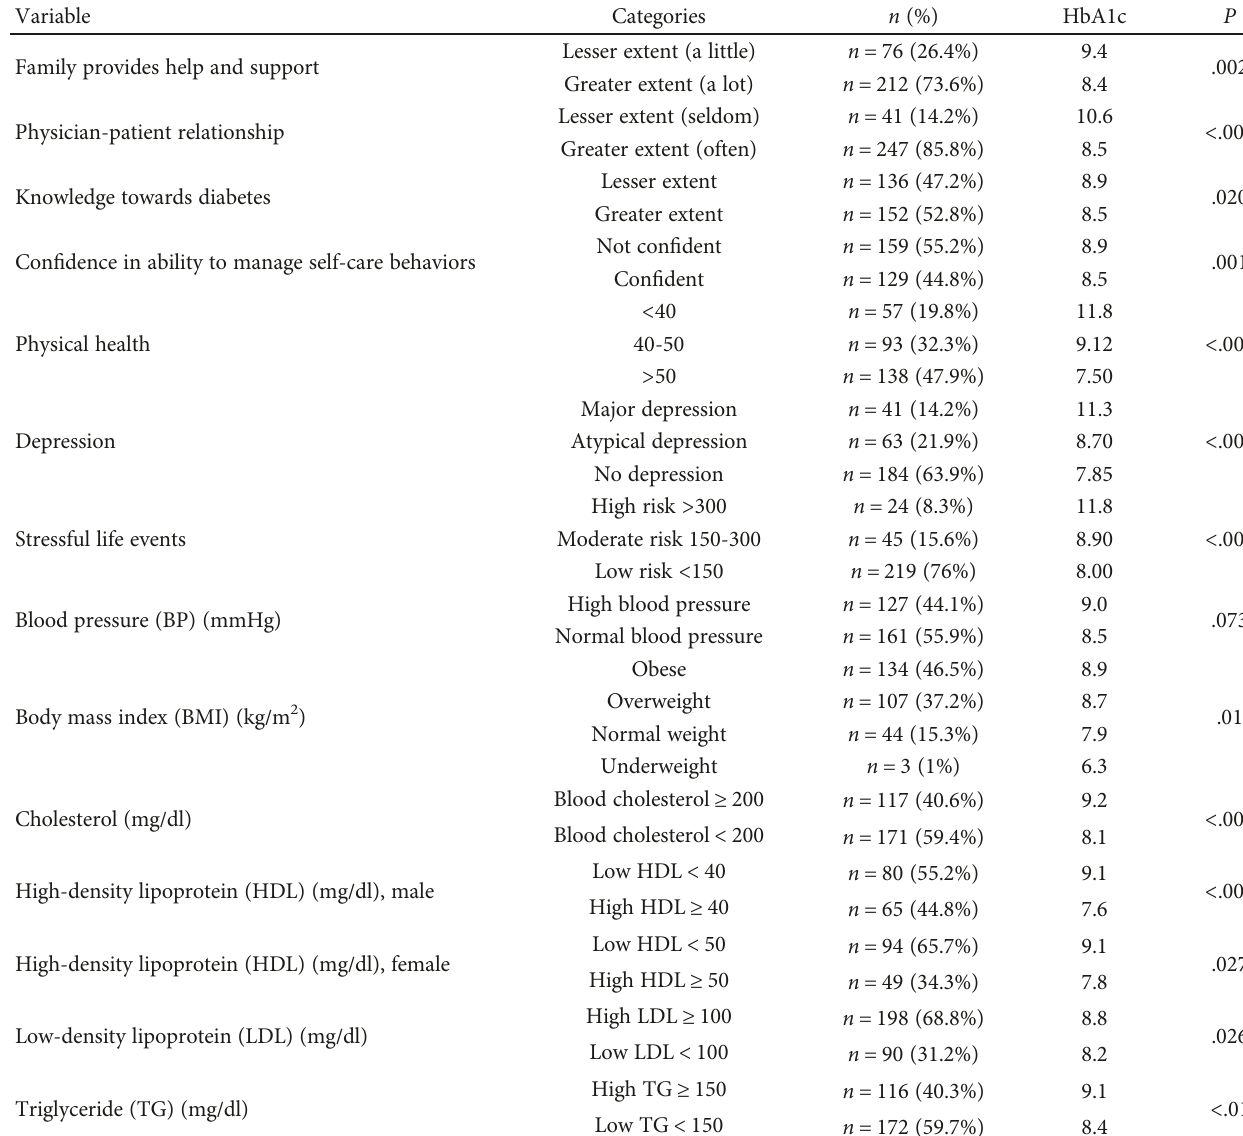
Table 4: Anthropometrics and HbA1c levels.